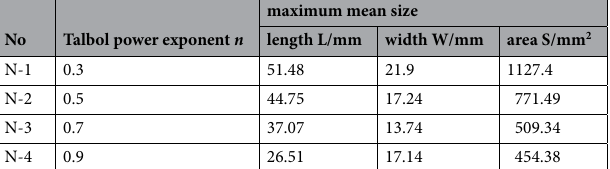
Table 7. Size of the water inrush channel at the top of the samples at all levels.